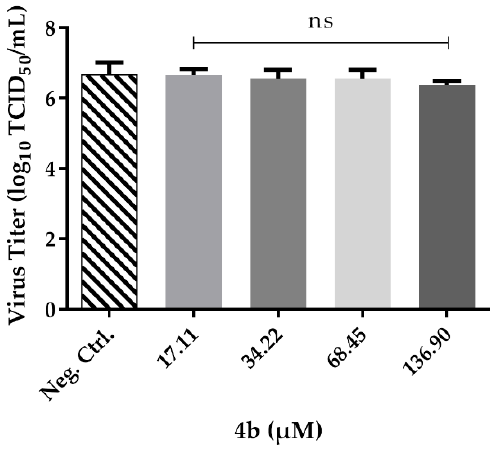
Figure 5. Graphic result for compound 4b in the pre-treatment test to ZIKV. Vero cells in a 48-well cell plate were treated with 4b in different concentrations and after 1 h the supernatant was discarded. Cells were washed with PBS 1X, ZIKV MOI 0.1 was inoculated, and the plate was incubated again. After five days, the supernatant was collected and titrated by TCID 50 method. The experiment was conducted in triplicates and values are the mean and the SD. In the GraphPad Prism program, Dunnett’s ANOVA analysis was used to determinate the best concentrations comparing with control. ns = not statistically significant for p < 0.05.